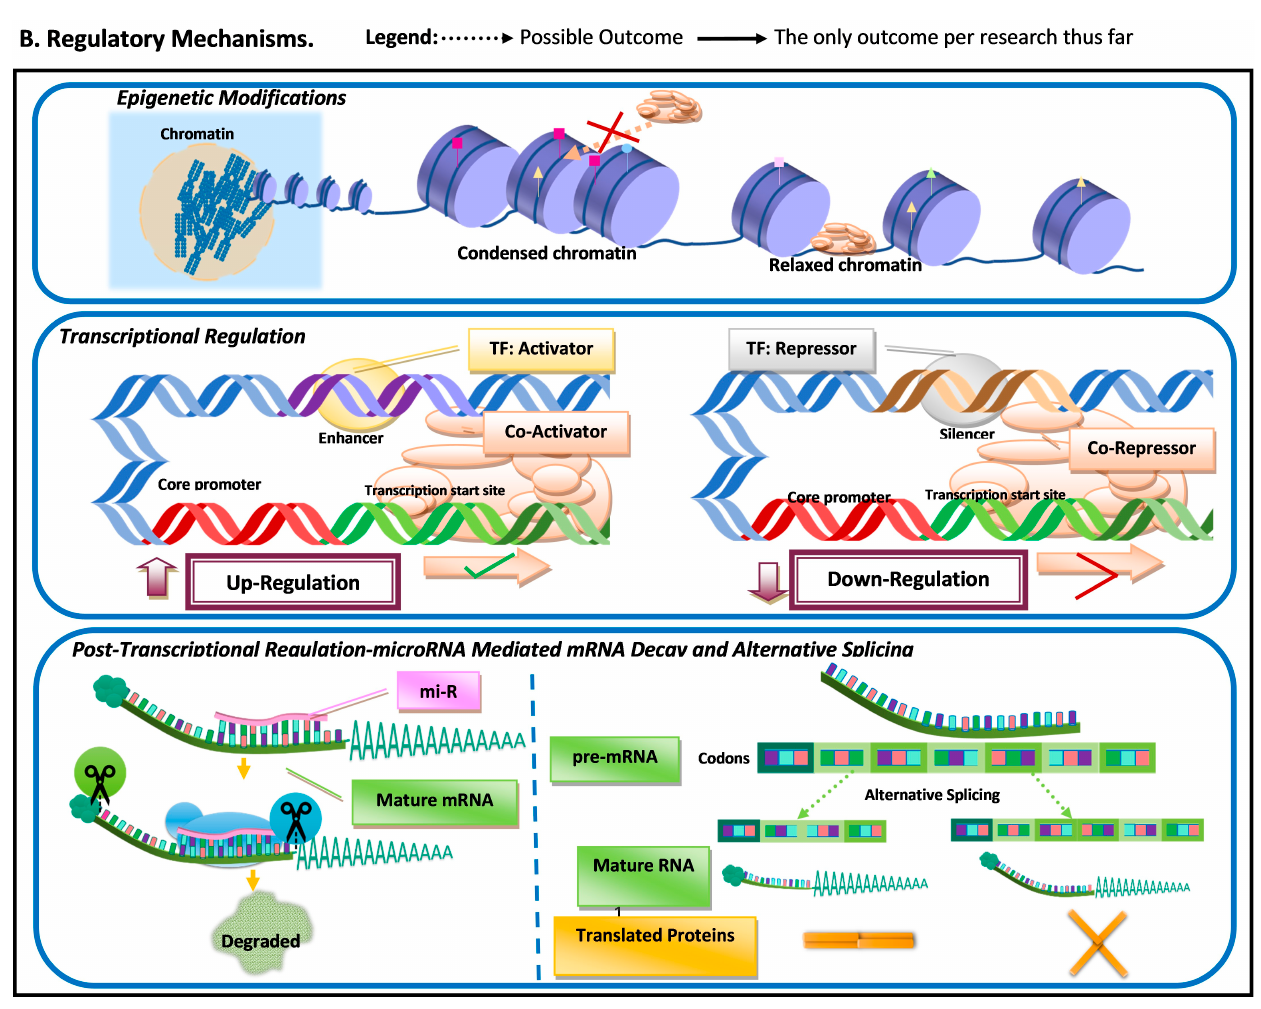
Figure 1. Schematic representation of the most common molecular mechanisms underlying adap- tive variation in vertebrates. ( A ) Sequence variation. Sequence variation refers to any change in DNA sequence that commonly occurs due to DNA polymerase errors (e.g., slippage and erroneous excisions) and/or insertion or deletion of transposable elements. DNA sequence variation in con- served elements (i.e., regulatory elements and coding regions) is the most common mechanism un- derlying adaptive variation in vertebrates and can lead to gene duplication, neogenization, and pseudogenization. Sequence variation in coding regions can lead to amino acid changes at or near functional domains, which can impact protein function and/or structure. Additionally, sequence variation at the coding regions can also lead to the emergence of microRNA (miR) or modification in existing miRs. MiRs can hybridize with target mRNA and can lead to its decay, thus downregu- lating gene expression. Sequence variation in regulatory elements can lead to increases (upregula- tion) or decreases (downregulation) in transcription of a gene. ( B ). Regulatory mechanisms. The three most common regulatory mechanisms underlying adaptive variation in vertebrates described thus far are epigenetic modifications, transcriptional regulation, and post-transcriptional regulation. Epigenetic modifications are modifications to histones, the protein component of nucleosomes. These modifications can impact an RNA polymerase’s ability to find core promoters as well the activity of transcription factors. Transcriptional regulation involves cis-regulatory elements and trans-regulatory elements, which impact the function of the transcription initiation complex (TIC). Post-transcriptional regulation involves elements that impact the messenger RNA transcript itself. One of these mechanisms is microRNA (mi-R)-mediated mRNA decay, a process that leads to the degradation and subsequent downregulation of said transcript. Another mechanism that can impact the translated protein structure and/or function is alternative splicing.